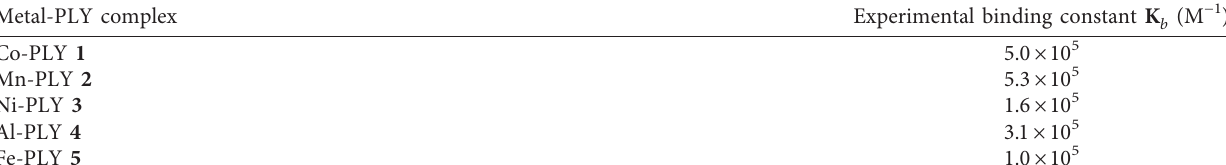
b ) between SS-DNA and metal complex (1 – 5) .